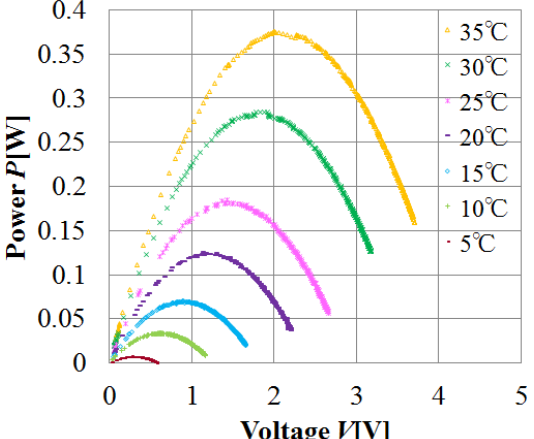
Figure 2. V-P Characteristic of the thermoelectric